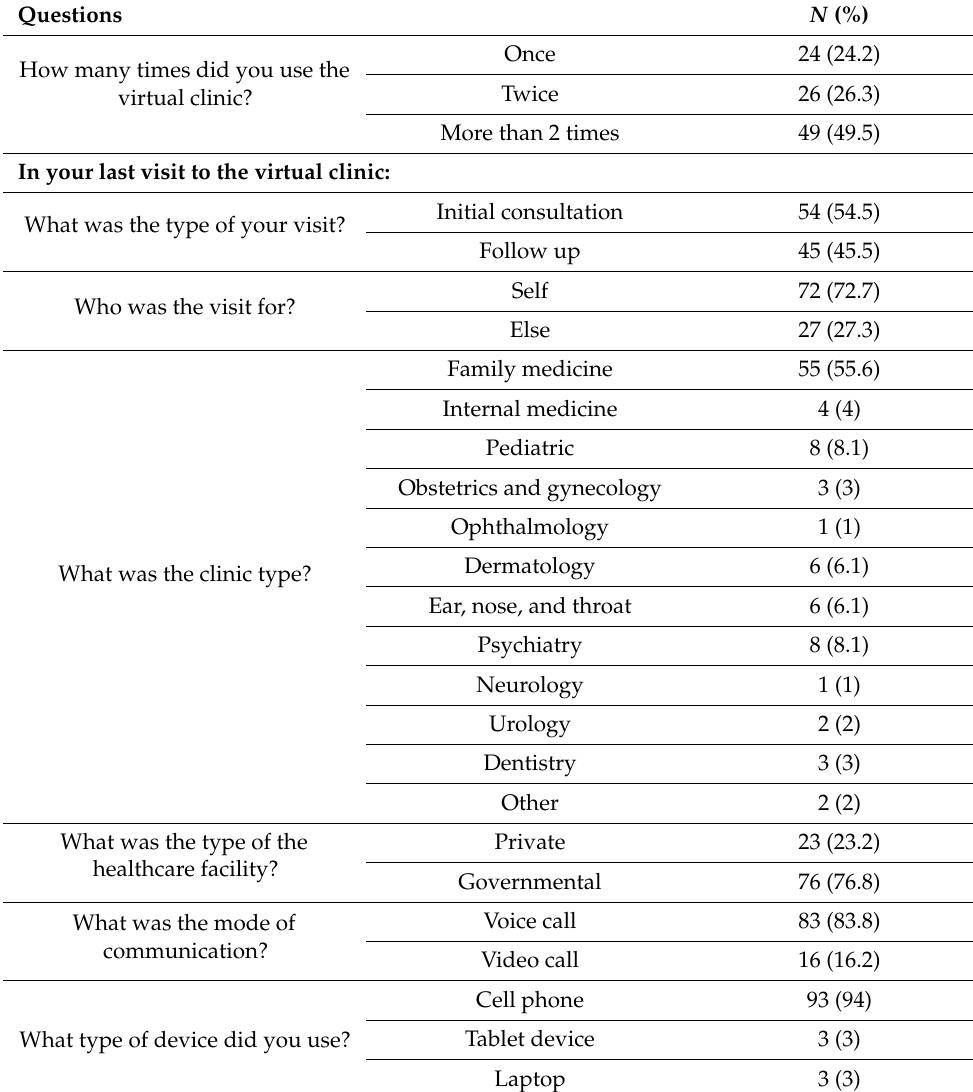
Table 2. Descriptive statistics for follow-up questions asked to virtual clinics users ( n =